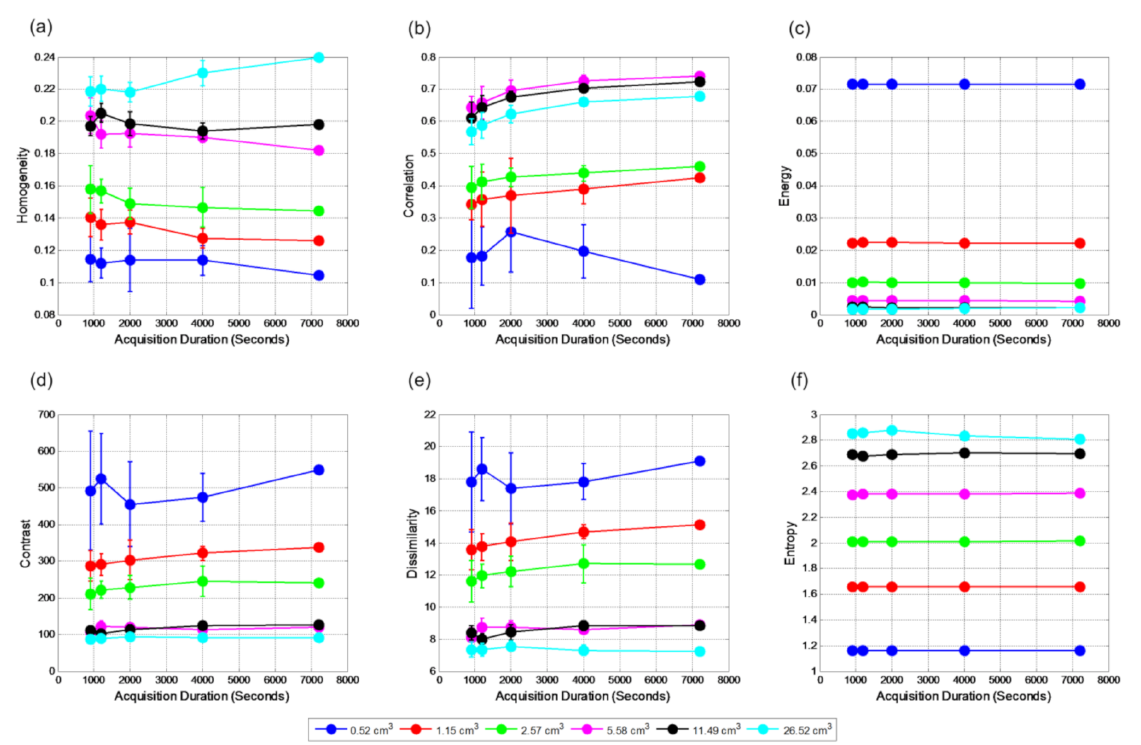
Figure 4. Six textural features vs. acquisition durations for VOI true , contrast 2:1, and quantization level 64. ( a ) Homogeneity, ( b ) contrast, ( c ) energy, ( d ) contrast, ( e ) dissimilarity and ( f )